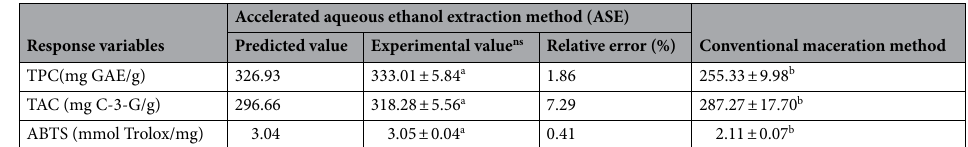
Table 5. Experimental and predicted values of the response variables at optimal extraction conditions of ASE along with the experimental value from conventional maceration method. TPC total phenolic content, mg GAE/g milligram gallic acid equivalents per gram extract, TAC total anthocyanin content, mg C-3-G/g milligram cyanidin-3-O-glucoside per gram extract. ABTS 2,2 ′ -azino-bis-3-ethylbenzothiazoline-6-sulphonic acid; mmol Trolox/mg millimole Trolox equivalents per milligram extract. ns is representation a nonsignificant difference between experimental and predicted values ( p > 0.05, One-Sample T-Test). a,b Values with different superscript letters between experimental values of ASE and conventional methods are representation a significant difference ( p ≤ 0.05, One-Sample T-Test).